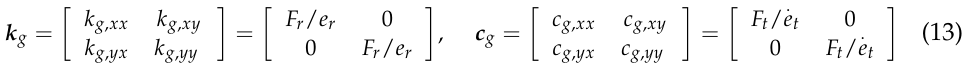
This is fulfilled if main stiffness and damping coefficients, in both directions, are equal and the cross-coupling coefficients are zero or equal in magnitude but with opposite signs: